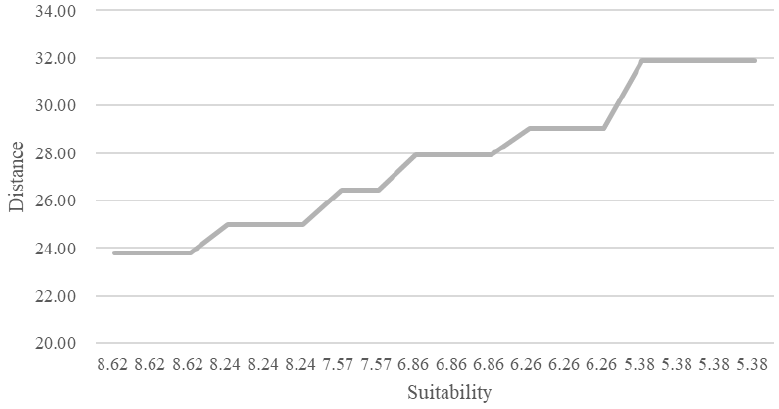
Figure 6. The first stage optimal Pareto solution.